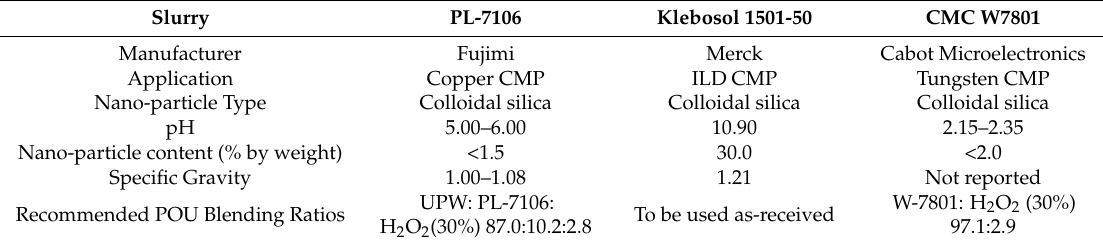
Table 1. Previously published properties and point-of-use blending specifications for each